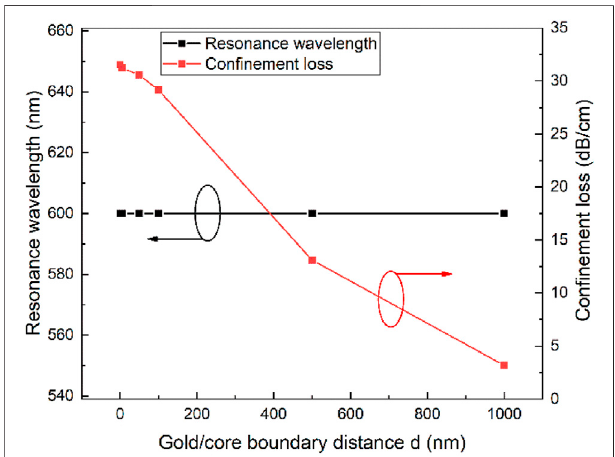
FIGURE 3 | Evolution of the resonance wavelength and con fi nement loss with gold/core boundary distance (d), for t g (cid:2) 40 nm, 5% GeO 2 doping concentration and n a (cid:2)